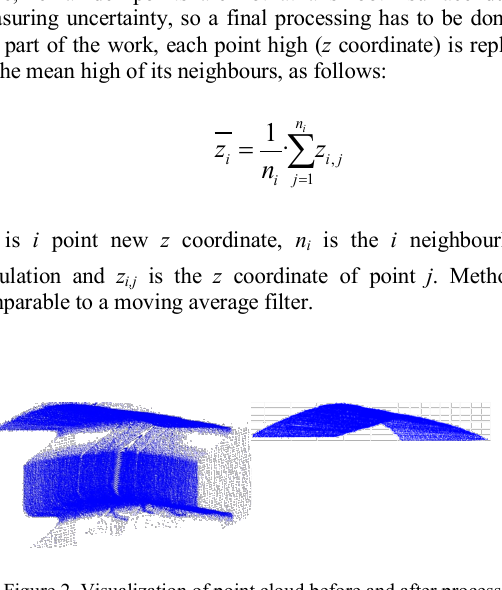
Figure 2. Visualization of point cloud before and after process. Figure 3. Height profile of a bended beam; blue lines if formed by centroids, and red one is formed by A points of each